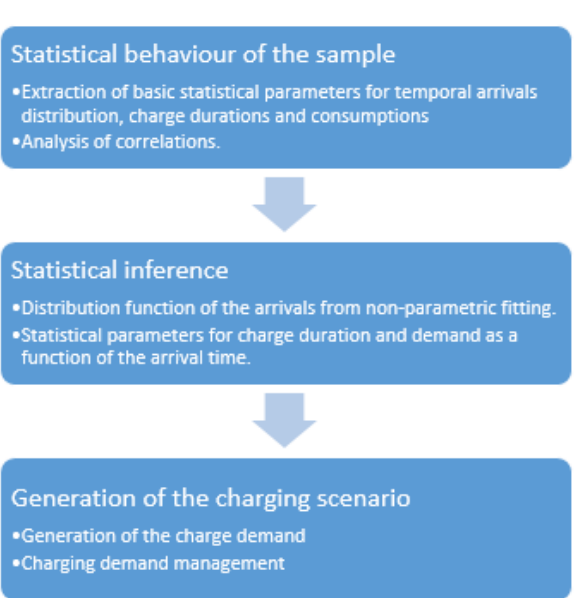
Figure 6. Workflow of the scenarios creation